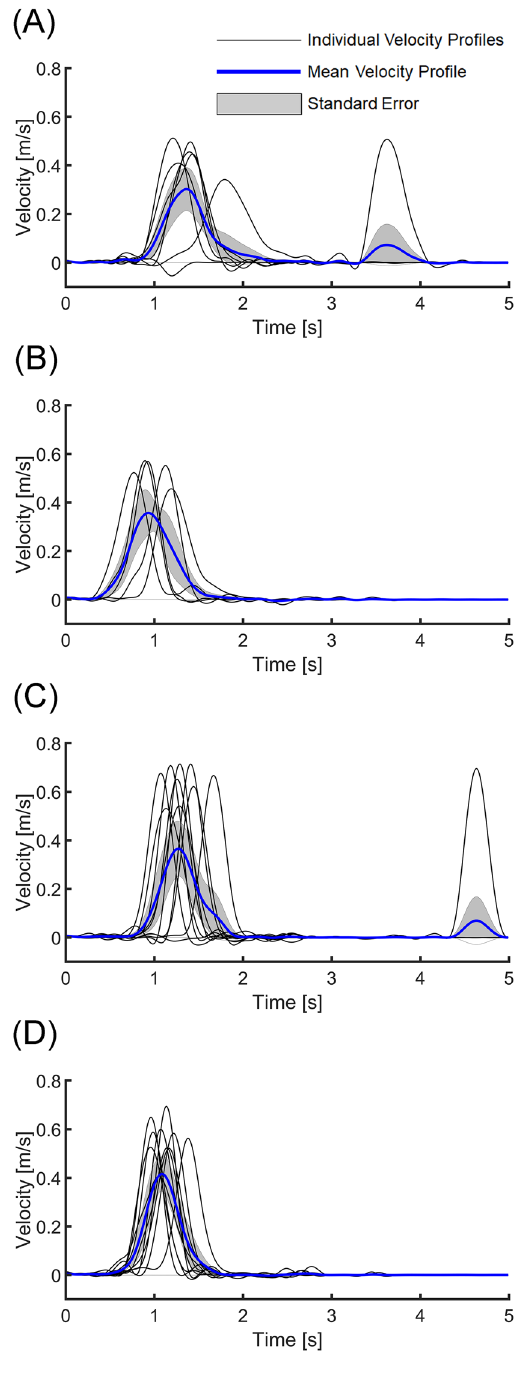
Figure 8. Exemplar tangential velocity profiles in different time points from a participant. ( A ) Tangential velocity profiles of the object movements at baseline test (7 successful trials out of 10 baseline trials are presented). Each thin black line indicates a velocity profile of a trial. A thick blue line indicates the mean velocity profile of the timepoint. Gray shade indicates the standard error. ( B ) Tangential velocity profiles of the object movements at the fifth block of practice (5 trials). ( C ) Tangential velocity profiles of the object movements at immediate retention test (10 successful trials out of 10 baseline trials are presented). ( D ) Tangential velocity profiles of the object movements at delayed retention test (9 successful trials out of 10 baseline trials are presented.). Refer to Supplementary Fig. 7 for further information about the success rate of the chopstick motor skill